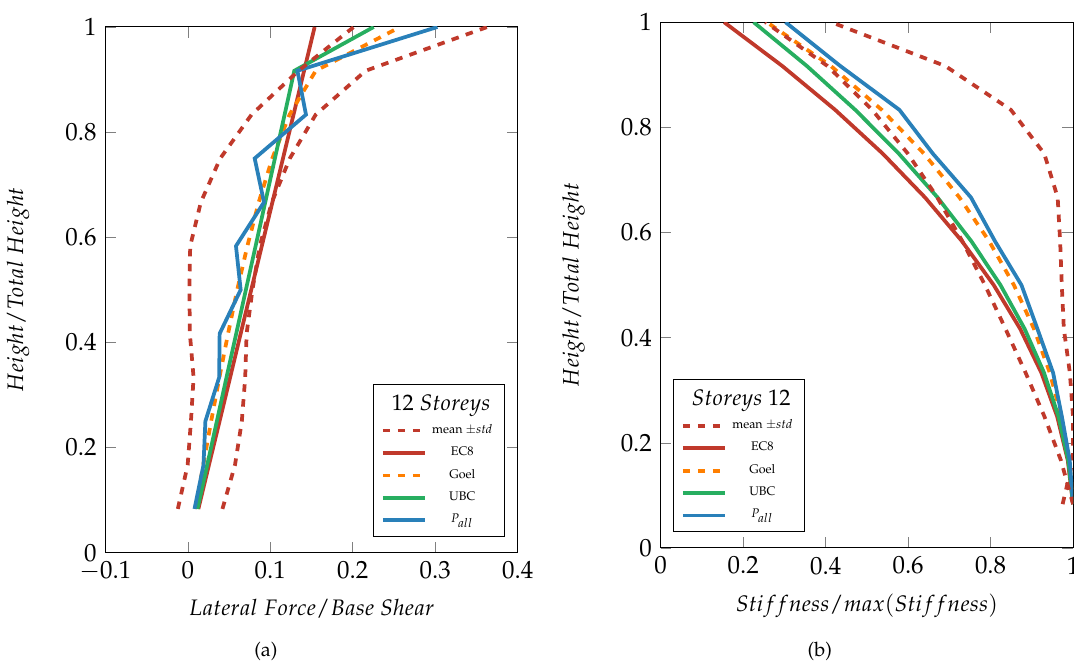
Figure 8. Lateral load patterns used to design the 12-storey SBM ( a ) and the related dimensionless stiffness patterns ( b ) compared with the solution provided by the